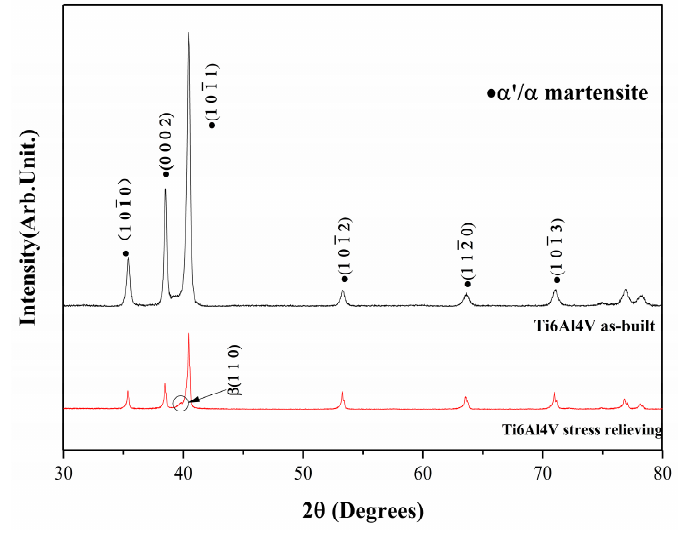
Figure 4. XRD patterns of as ‐ built and stress relieving samples.